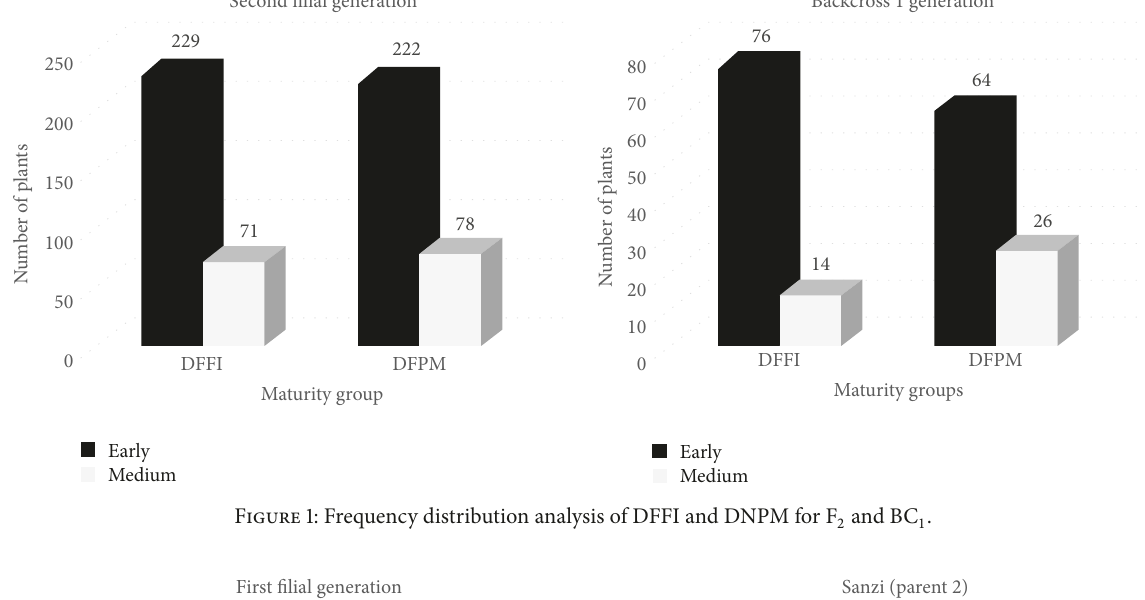
Figure 1: Frequency distribution analysis of DFFI and DNPM for F 2 and BC 1 .